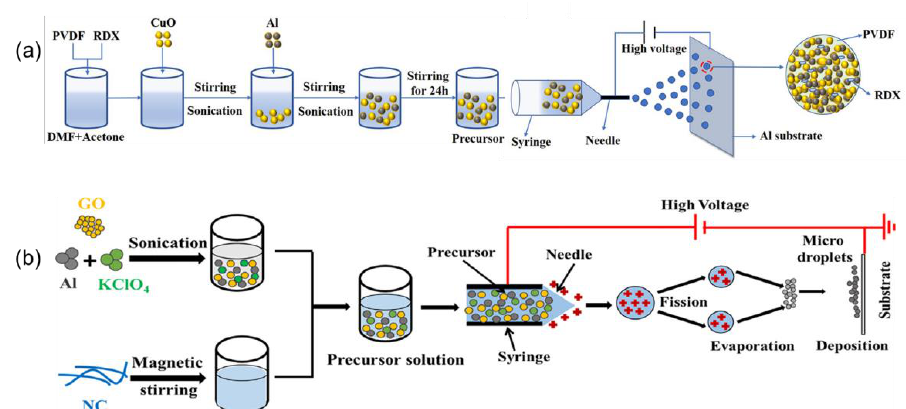
Figure 6. Schematic illustration of ( a ) quaternary Al/CuO/PVDF/RDX microspheres [86] Copyright 2021, Chemical Engineering Science, and ( b ) quaternary NC/GO/Al/KClO 4 nEMs [87], respectively. Copyright 2021, Combustion and Flame.